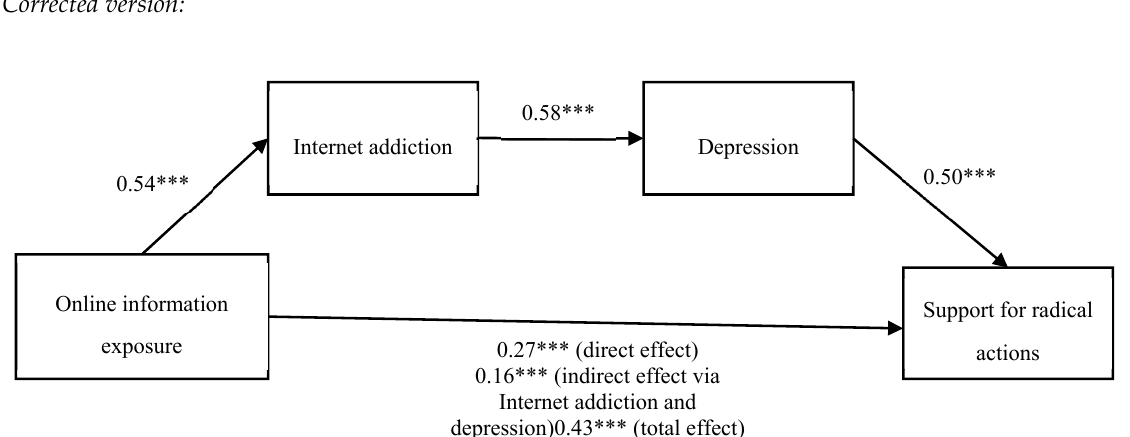
Figure 1. Analysis of the mediating effect of Internet addition and depression on online information exposure and support for radical actions. The entries are standardized coefficients. Missing values are replaced by means. N = 290. *** p < 0.001. Gender, age, SES, birthplace, attitudinal support for Anti-ELAB, and participation in Anti-ELAB are included in the analysis, but they are not shown in this figure for simpler demonstration.